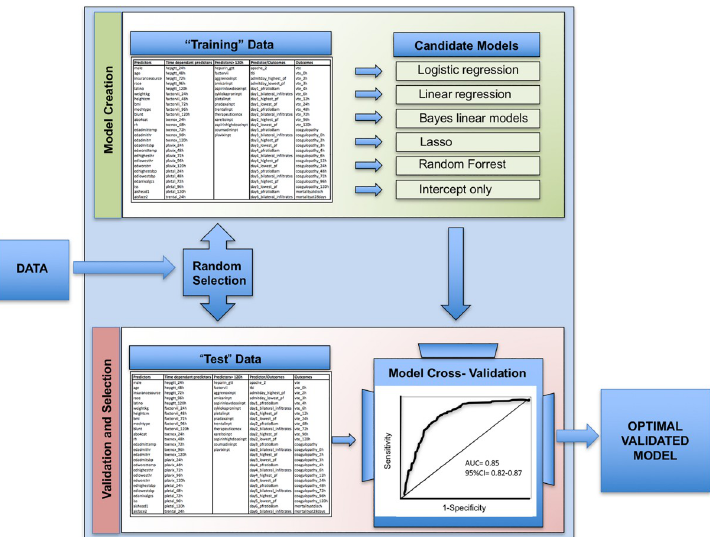
Fig 1. SuperLearner prediction. A simplified schematic of the SuperLearner selection of optimized models from large datasets using an unbiased approach of potential predictors. AUC, Area Under the Curve; CI, Confidence Interval. Candidate models listed are intended to be examples and do not represent all models used in this